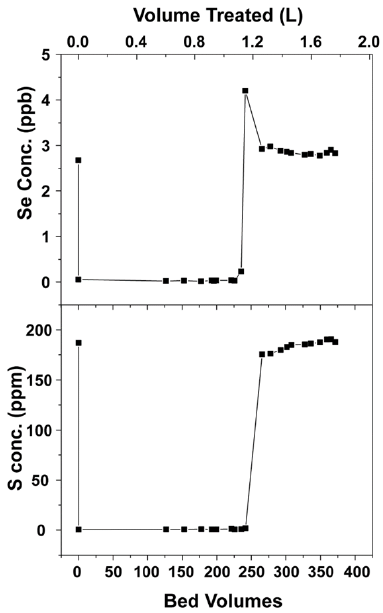
Figure 3. Se and S breakthrough curves of 1.1 cm diameter column test with granular layered double hydroxide (LDH) as bed material to treat cooling tower blowdown water .